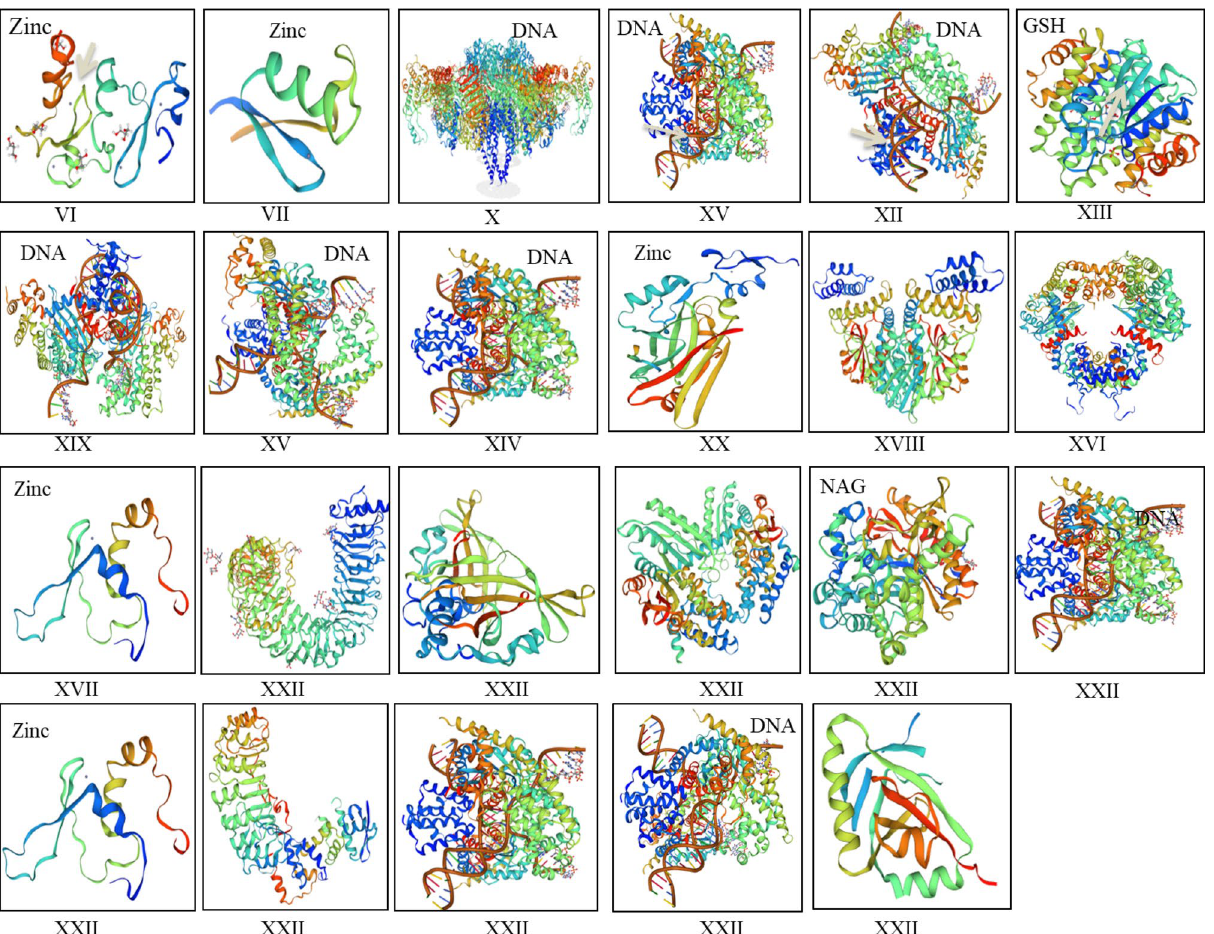
Figure 5. Protein 3D models for different classes of Zf-BED with their ligands; Zinc, DNA,